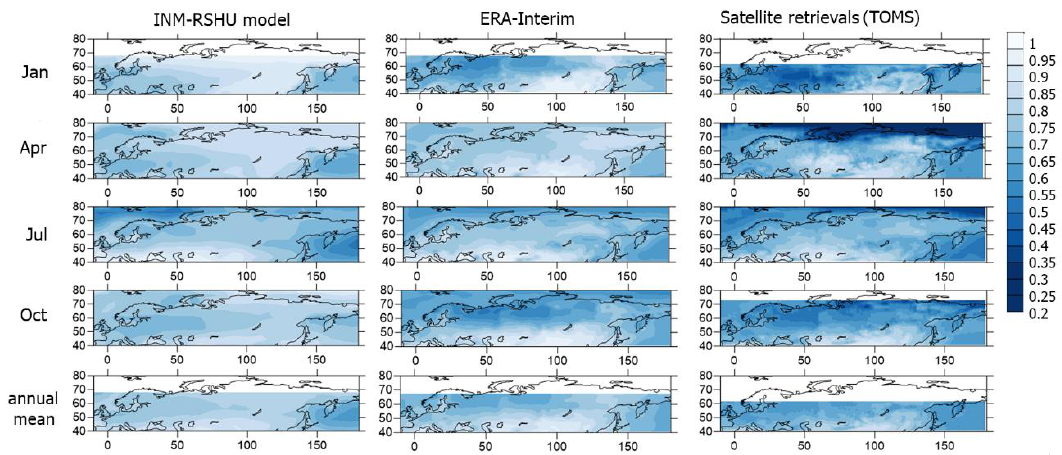
Figure 4. Climatology of the cloud modification factor ( CMFuv ) according to different datasets over the 1979–2015 period. Note, that the satellite CMFuv climatology has been obtained according to the